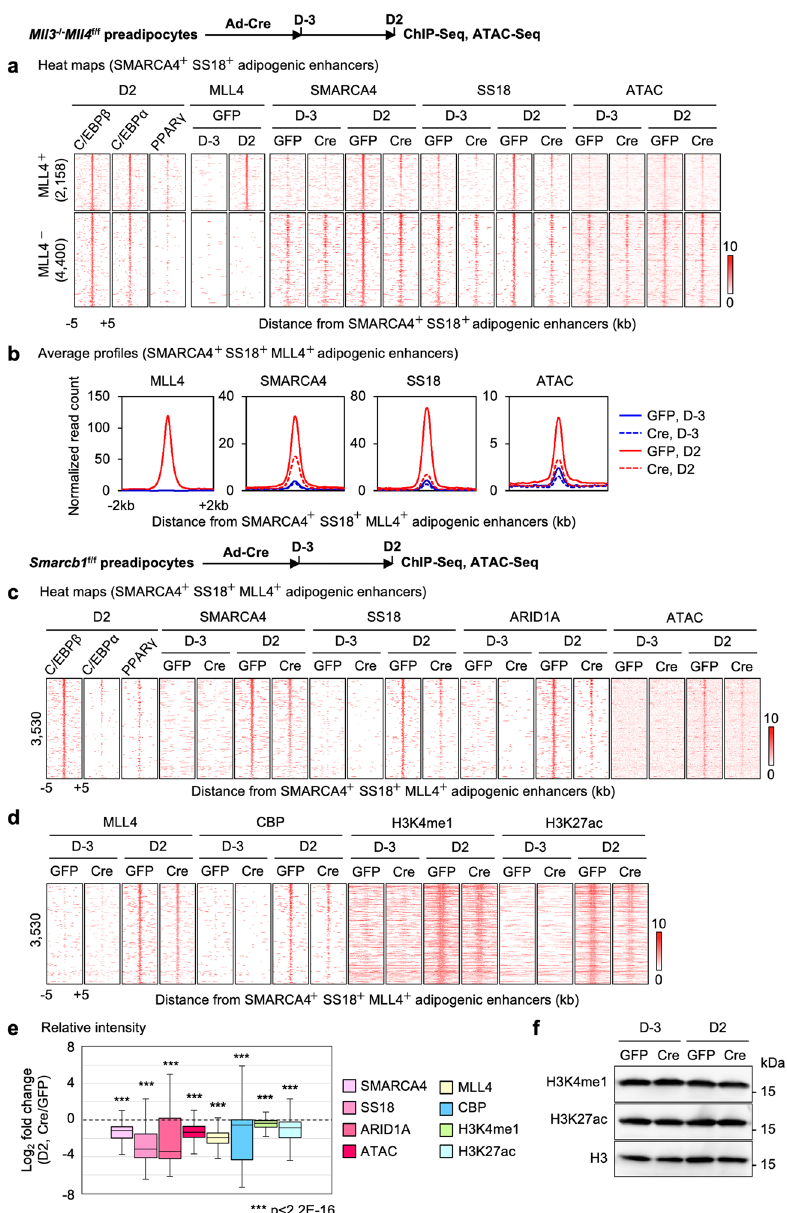
Fig. 5 Reciprocal regulation between BAF and MLL4 on active enhancers during adipogenesis. Mll3 ‒ / ‒ Mll4 f/f or Smarcb1 f/f brown preadipocytes were infected with adenoviruses expressing GFP or Cre, followed by adipogenesis assays. Cells were collected before (D-3) and during (D2) adipogenesis for ChIP-Seq, ATAC-Seq and Western blot analyses. a , b Decreased SMARCA4 and SS18 binding and chromatin accessibility on adipogenic enhancers in Mll4 KO (Cre) cells during adipogenesis. Adipogenic enhancers were de fi ned as active enhancers bound by either C/EBP β , C/EBP α , or PPAR γ at D2 of adipogenesis. Published ChIP-Seq data sets for C/EBP β , C/EBP α , and PPAR γ were used (GSE74189) 18 . Heat maps around SMARCA4 + SS18 + adipogenic enhancers ( a ) and average pro fi les around SMARCA4 + SS18 + MLL4 + adipogenic enhancers ( b ) are shown. Adipogenic enhancers shown in the heat maps were ranked by the binding intensity of SMARCA4 at the center in D2 control (GFP) cells. c – f Deletion of Smarcb1 reduces binding of BAF subunits (SMARCA4, SS18, and ARID1A) as well as chromatin opening, and impairs MLL4 binding and activation of adipogenic enhancers. Adipogenic enhancers at D2 of adipogenesis were re-de fi ned using ChIP-Seq data sets obtained in Smarcb1 f/f cells. c Heat maps for ChIP-Seq of BAF subunits (SMARCA4, SS18, and ARID1A) and ATAC-Seq around the center of SMARCA4 + SS18 + MLL4 + adipogenic enhancers. d Heat maps for ChIP-Seq of MLL4, CBP, H3K4me1 and H3K27ac on adipogenic enhancers. Adipogenic enhancers shown in the heat maps were ranked by the intensity of SMARCA4 at the center in D2 control (GFP) cells. e Fold changes of intensities between control (GFP) and Smarcb1 KO (Cre) cells on adipogenic enhancers ( n = 3530) are shown in box plots. The box represents the fi rst and third quartiles with the horizontal line showing the median, and whiskers indicating minimum and maximum in all box plots. Outliers were not included. Statistical signi fi cance levels are as follows (Wilcoxon signed rank test, one-sided): SMARCA4 ( p = 0); SS18 ( p = 0); ARID1A ( p = 6.3E-101); ATAC ( p = 0); MLL4 ( p = 4.5E-281); CBP ( p = 0); H3K4me1 ( p = 0); H3K27ac ( p = 0). Exact p-values cannot be computed for SMARCA4, SS18, ATAC, CBP, H3K4me1 and H3K27ac due to ties in the ranks. f Western blot analyses of H3K4me1 and H3K27ac in control and Smarcb1 KO cells during adipogenesis. Total histone H3 was used as a loading control. n = 3 biological